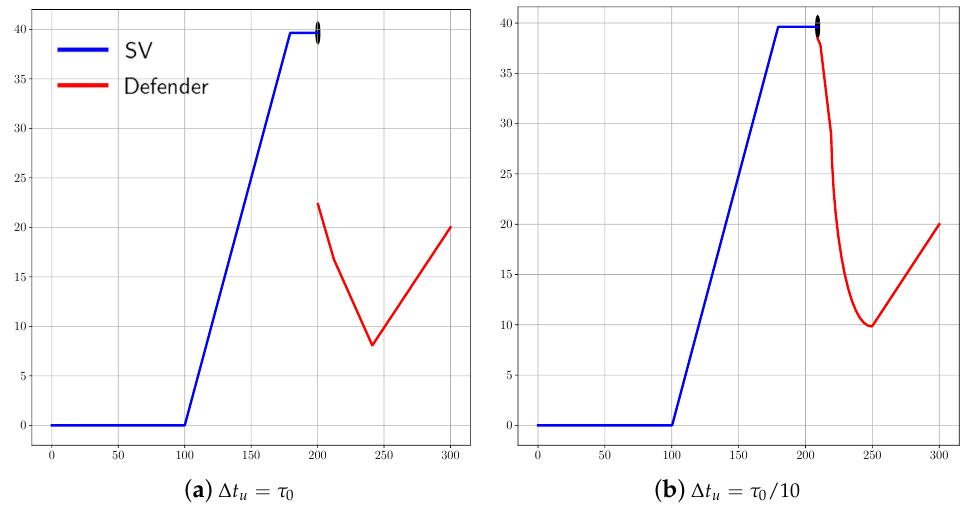
Figure 8. Interception trajectories with different values of ∆ t u .